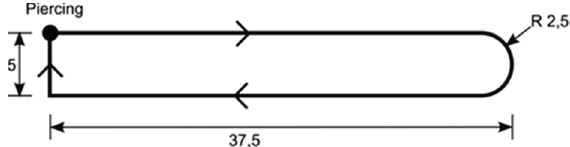
Figure 1. Geometry of the test pattern cut clockwise (dimensions in